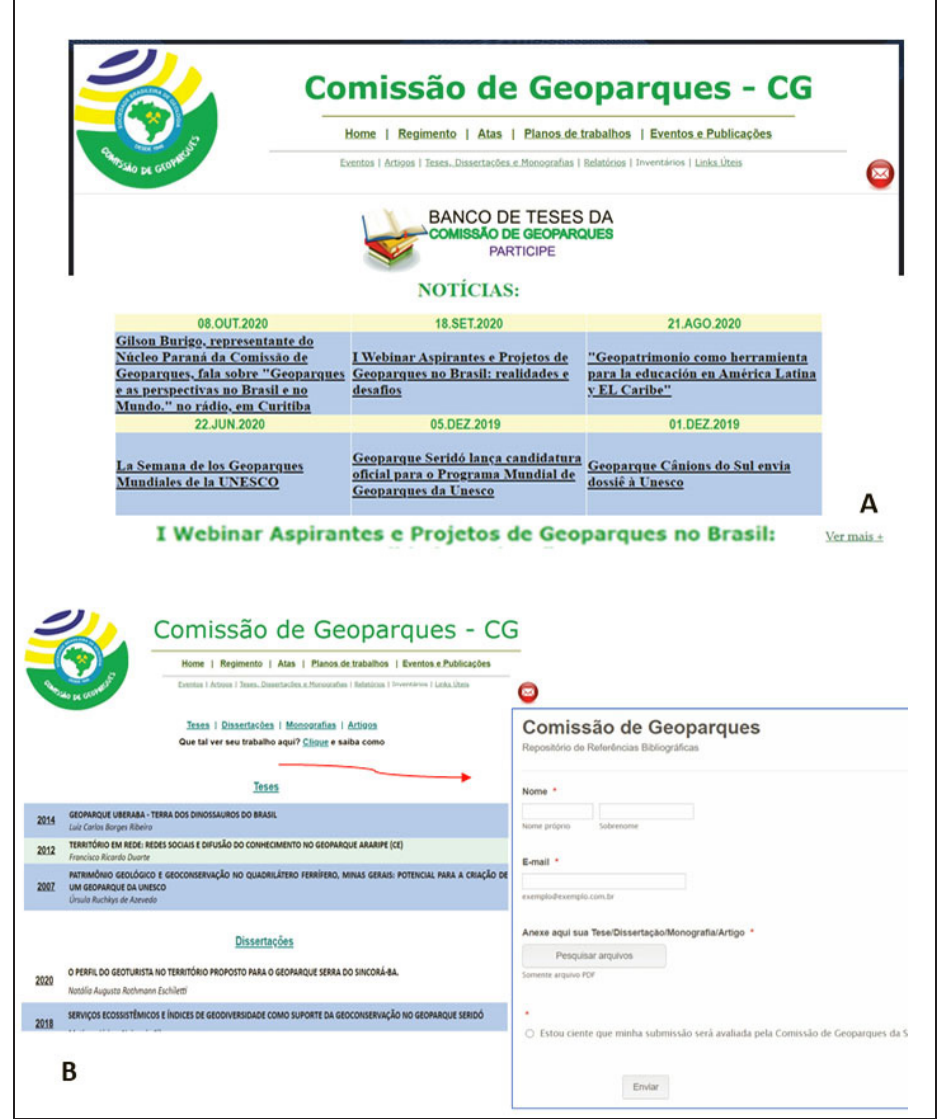
FIGURE 4. CG-SBG website: A – partial view of the homepage; B – publications and form for the visitor to submit their scientific production related to geoparks for publication on the